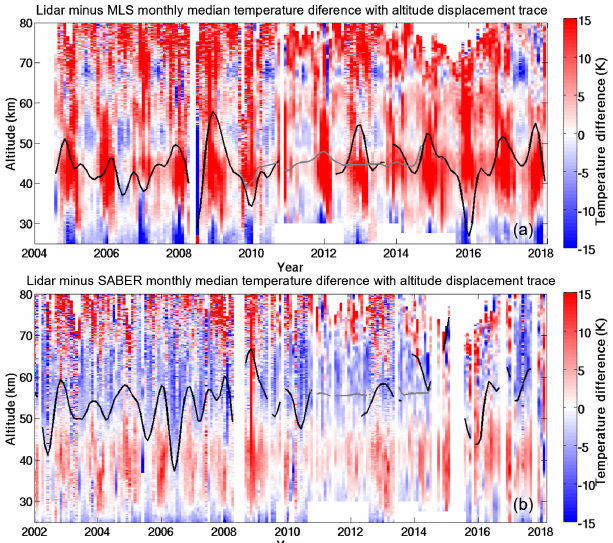
Figure 11. Panel (a) features the monthly median temperature dif- ferences between the lidar and MLS seen in Fig. 5, with the es- timated vertical displacement of the stratopause height overlaid. Panel (b) features the monthly median temperature differences be- tween the lidar and SABER seen in Fig. 3, with the estimated verti- cal displacement of the stratopause height overlaid. The black line represents comparisons between LTA and the satellite, and the grey line represents comparisons between LiO 3 S and the satellite.